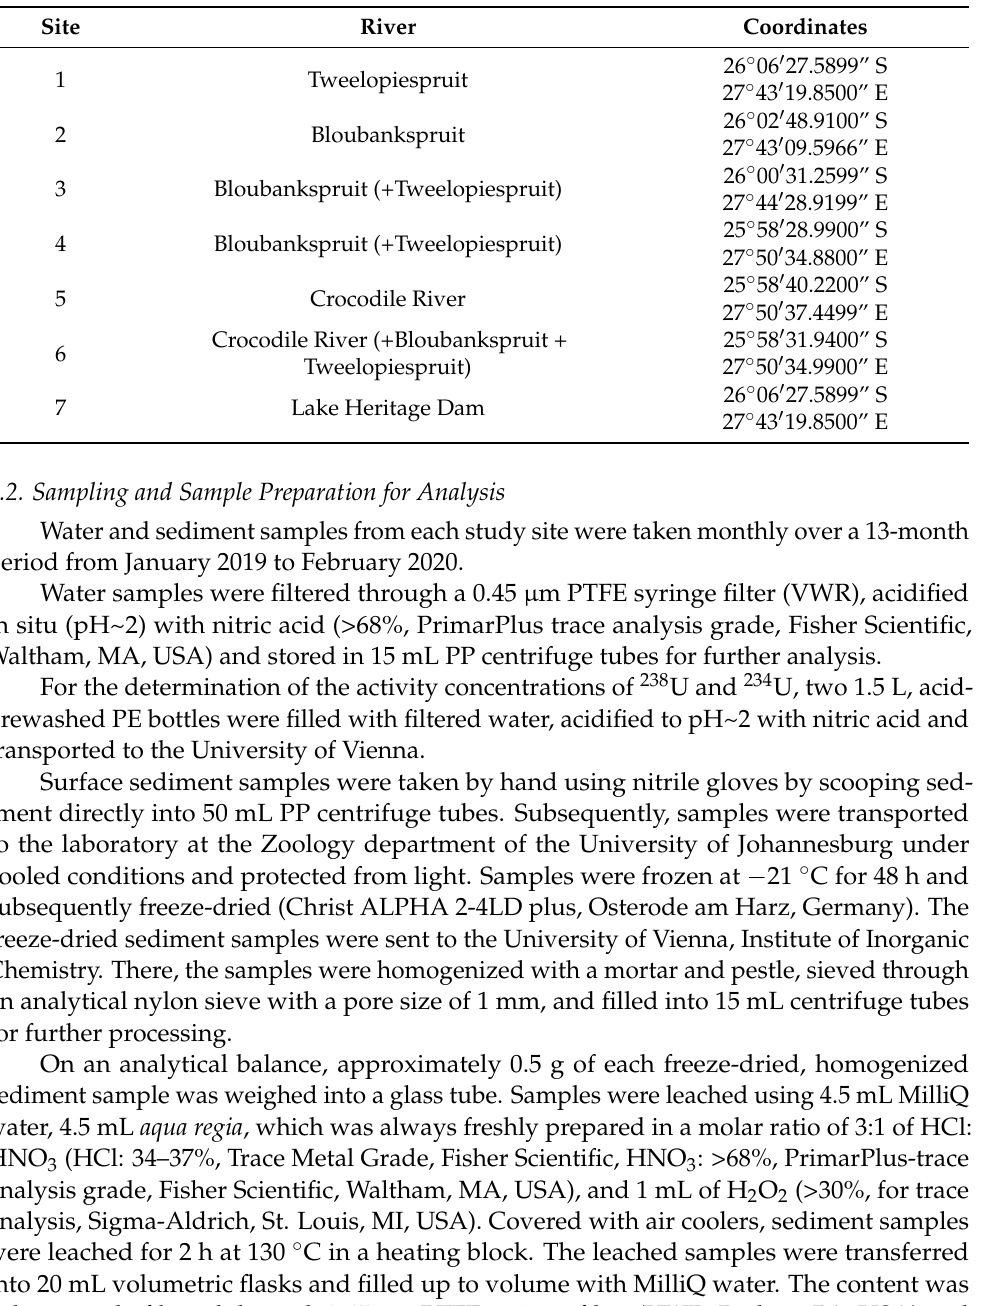
Table 1. Coordinates of sampling sites and information on the respective rivers at each